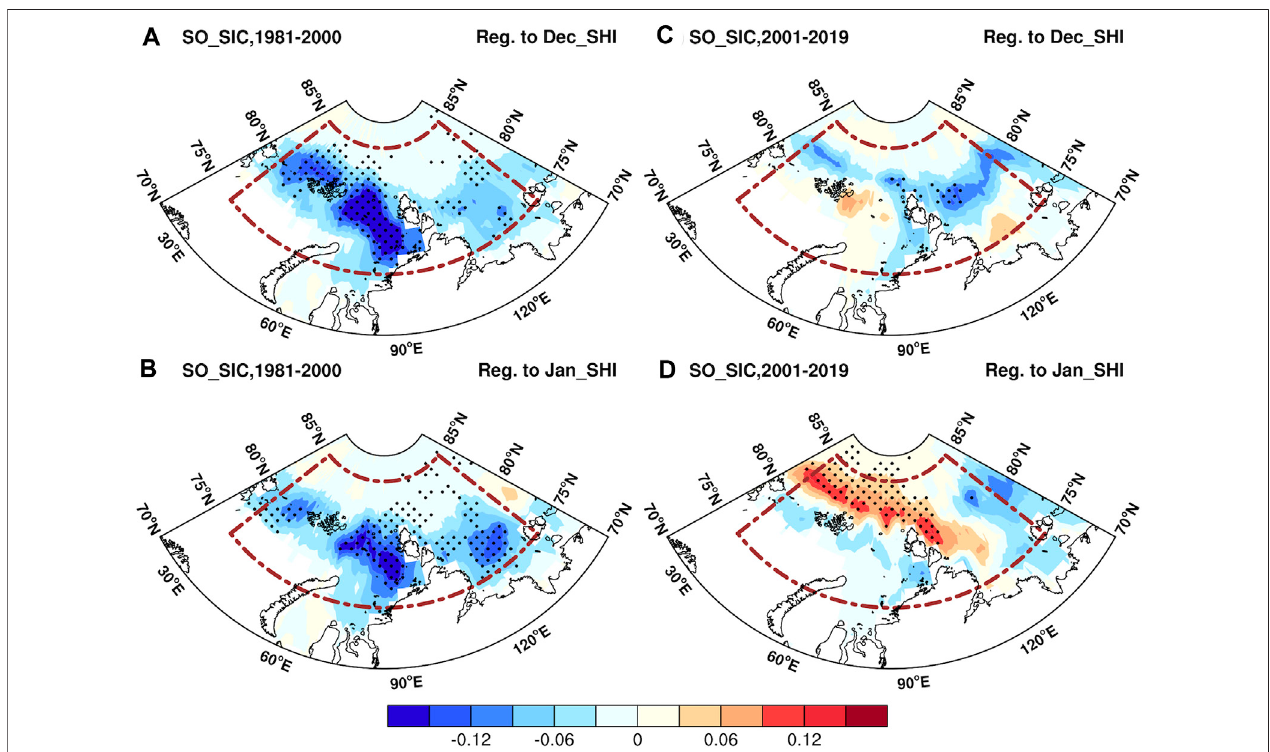
FIGURE 9 | Regressions of September – October sea-ice concentration (SIC) on the (A) December and (B) January Siberian high intensity index (SHI), separately, during 1980/81 – 1999/2000. (C – D) Asin(A – B)butduring 2000/01 – 2018/19. Dottedregionsarestatisticallysigni fi cantatthe90%con fi dencelevel,basedonthe t -test. The brown rectangle represents the key area of SIC over the Barents to Laptev Sea [BLSIC, (75 ° – 85 ° N, 30 ° – 140 ° E)].